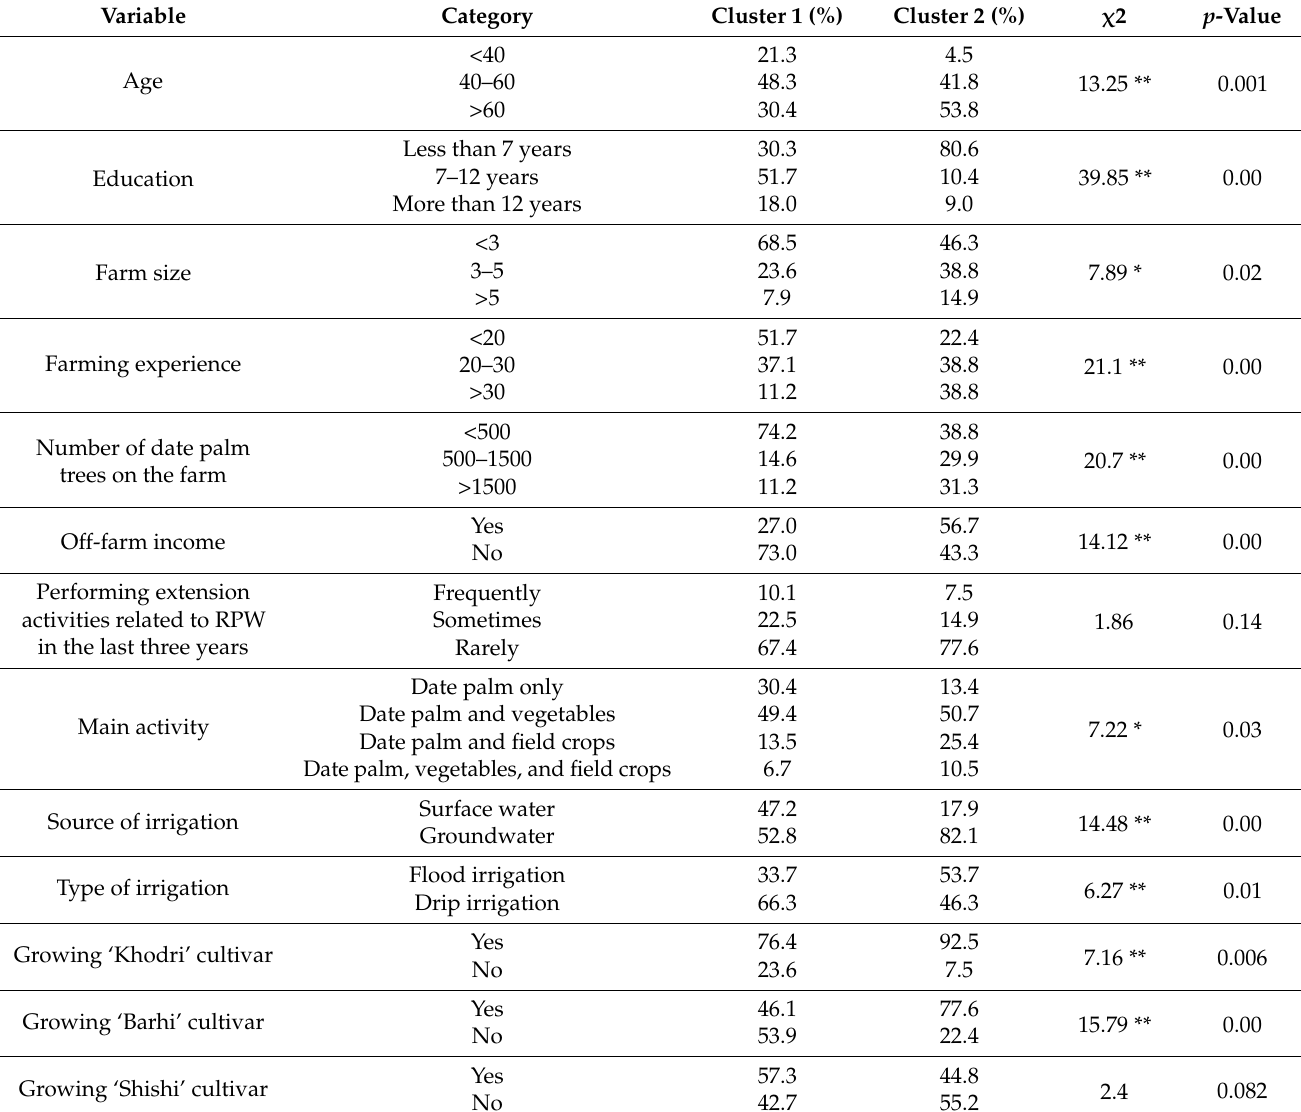
Table 5. Differences between the farmer clusters according to their socio-economic attributes and farm